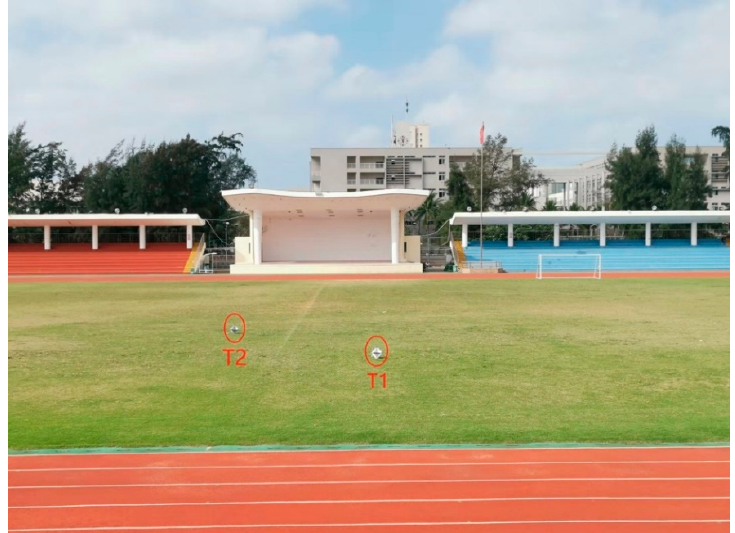
Figure 13. Scenario for the measured data set collection with 2 highlighted targets.